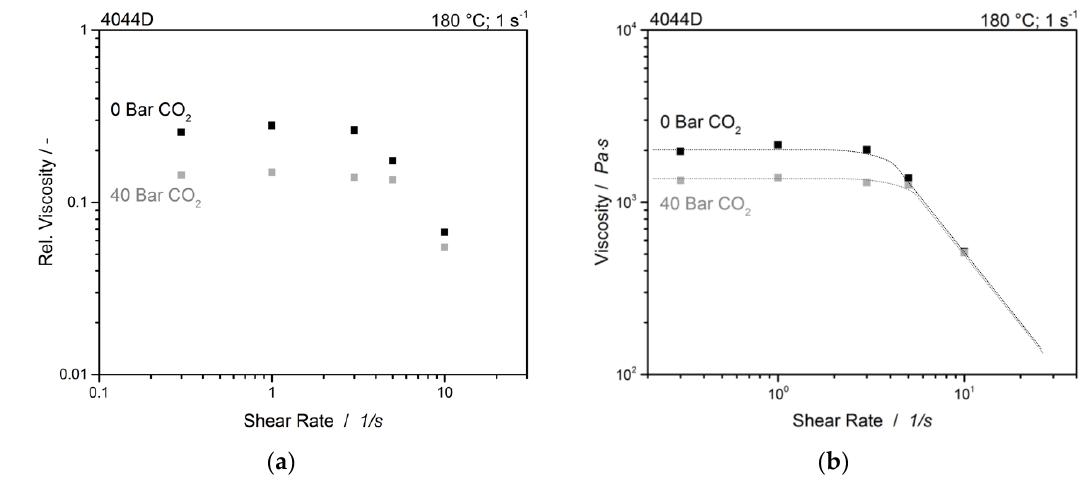
Figure 6. ( a ) Relative viscosities and ( b ) Steady state viscosities at different CO 2 pressures of unmodified PLA.